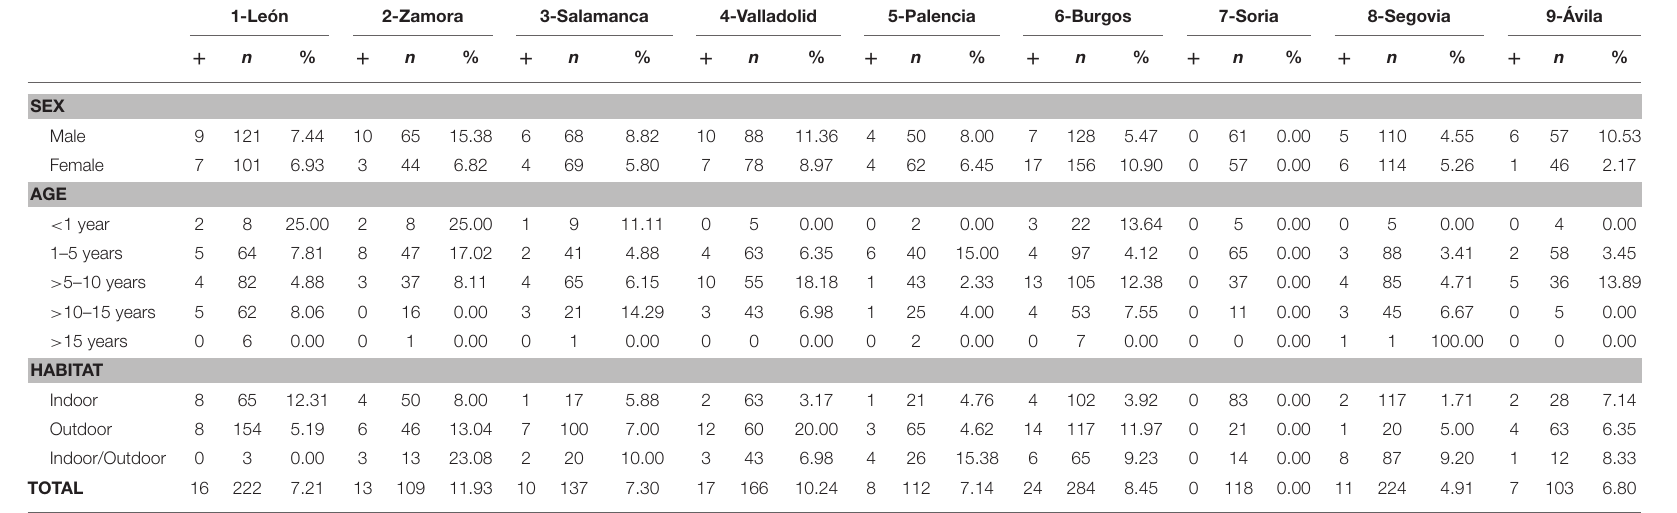
TABLE 2 | Numbers of dogs sampled and prevalence of D. immitis by sex, age, and habitat in the nine provinces of Castilla y León,